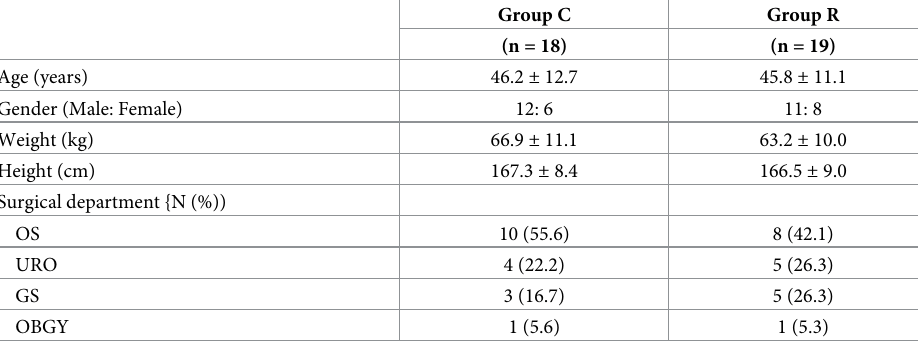
Table 2. Demographic and clinical data in the study during induction.